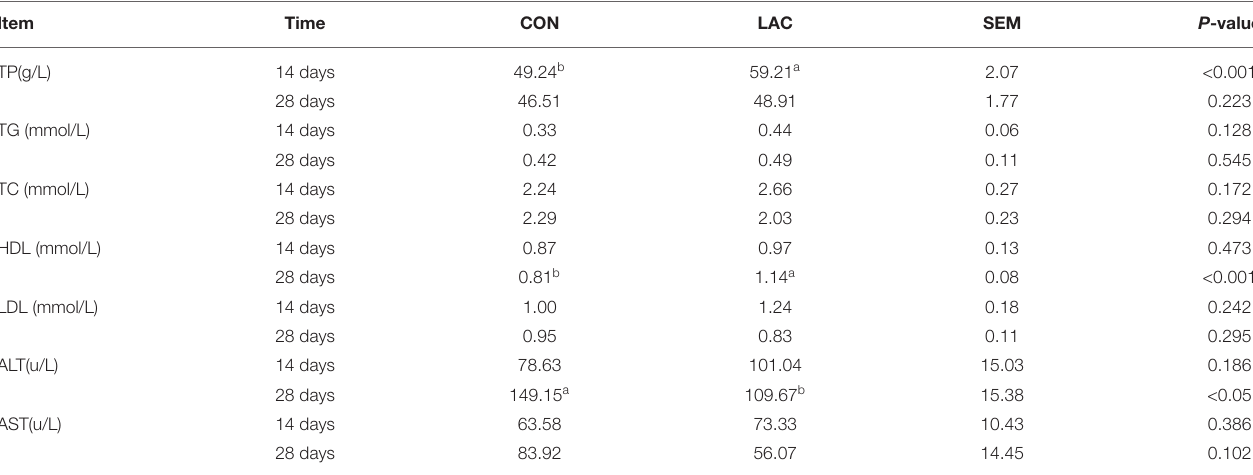
TABLE 3 | Effects of Lactobacillus delbrueckii on serum biochemistry parameters in the weaned piglets. Item Time